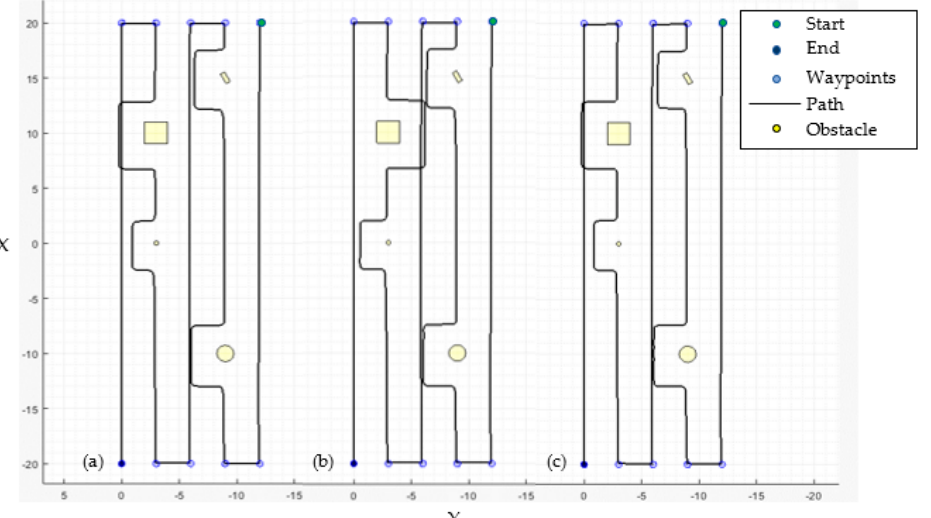
Figure 16. Area coverage in 3-m path gap mission with ( a ) 10% liquid load, ( b ) 50% liquid load, ( c ) 100% liquid load.